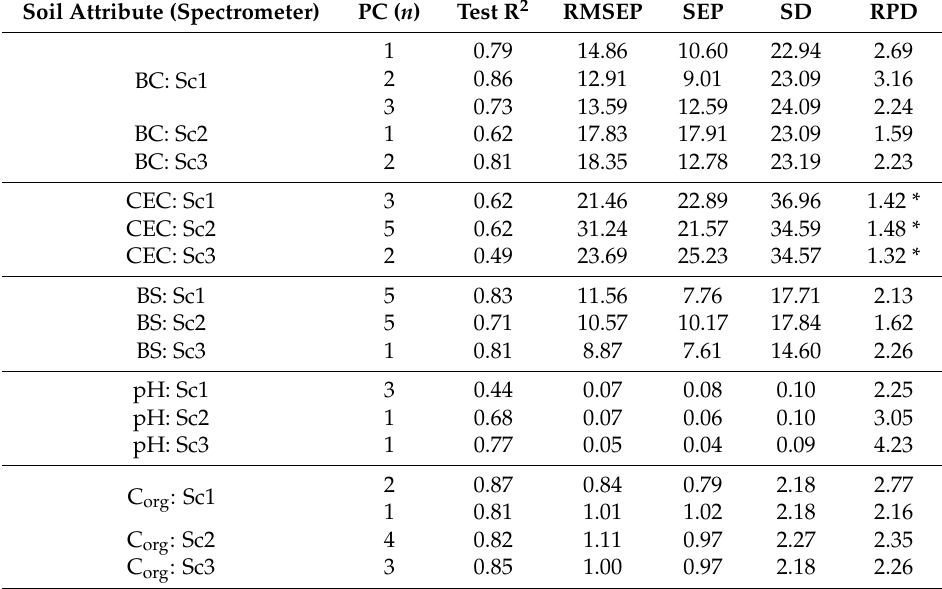
Table 5. PLSR Models for BC, CEC, BS, pH, C org : the best model statistics using the three different